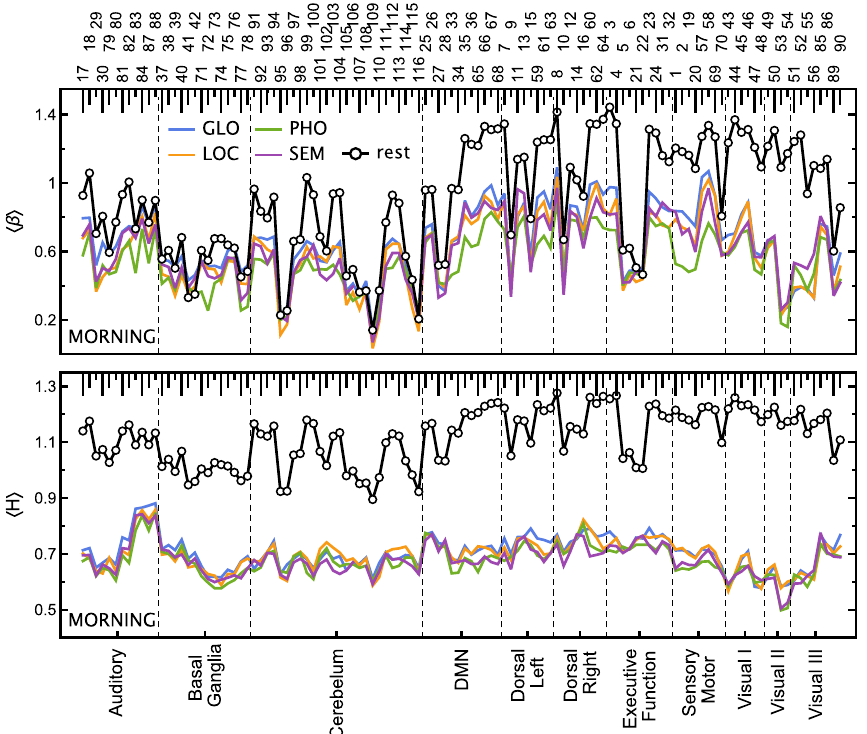
Figure 2. Plots of the spectral, β , and Hurst, H , scaling exponents estimated for the entire time series. The exponents were calculated for each ROI and ordered on the plot according to the AAL atlas (top labels) and resting-state networks (bottom labels). For evening session results, see Supplementary Fig. A.2. visual-verbal tasks ( SEM semantic, PHO phonological), visual-nonverbal tasks ( LOC local information processing, GLO global information processing), resting-state